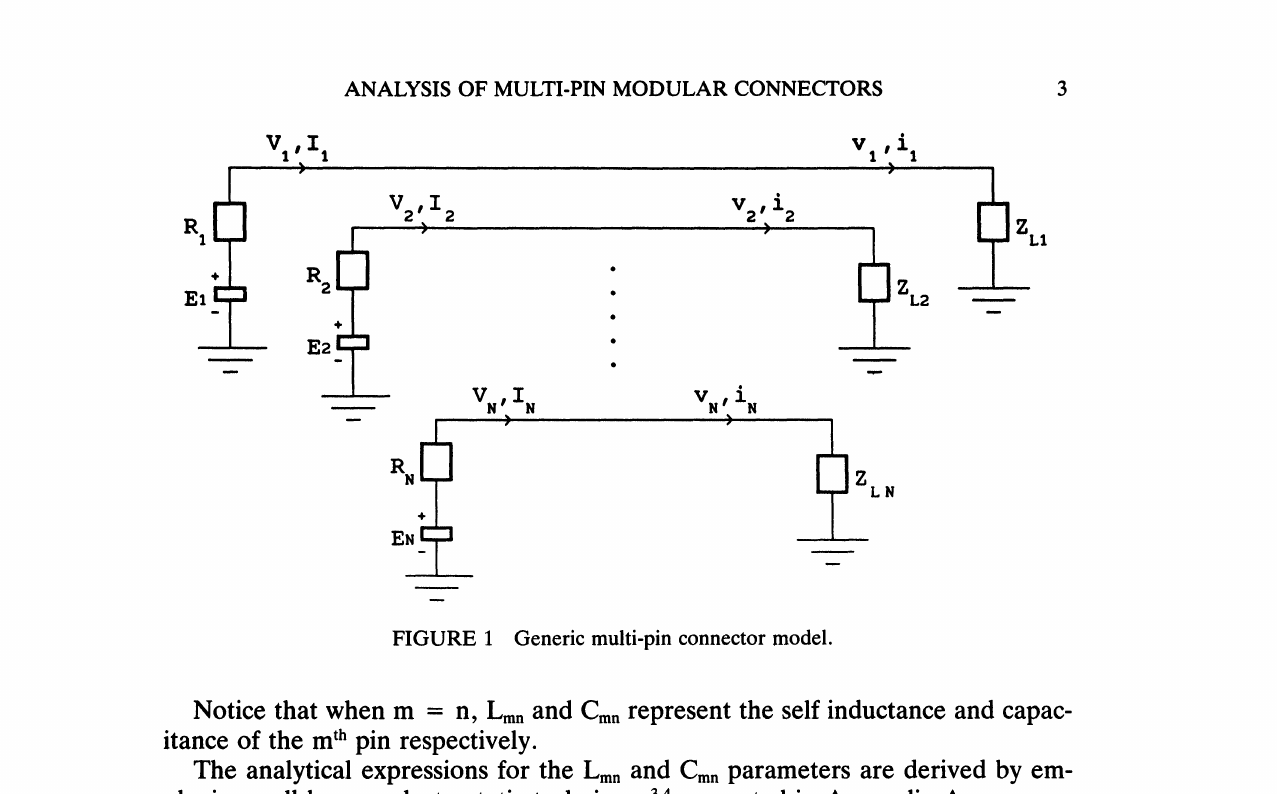
FIGURE Generic multi-pin connector